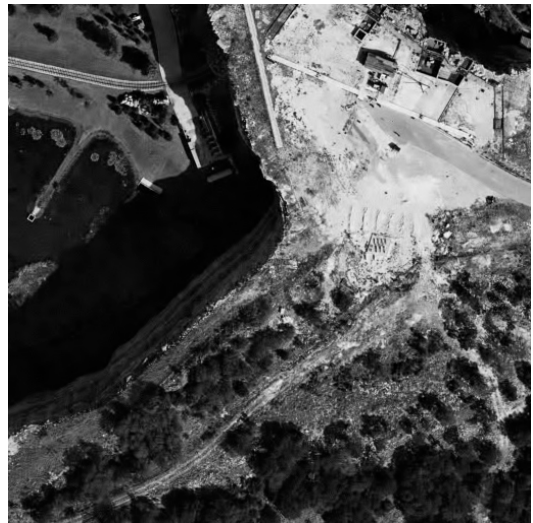
Figure 9. Filtered noisy image by 3D-DCT ( β = 3.0) with reference transformed by second order polynomial (PSNR out = 35.34 dB; PHVSM out = 39.24 dB).